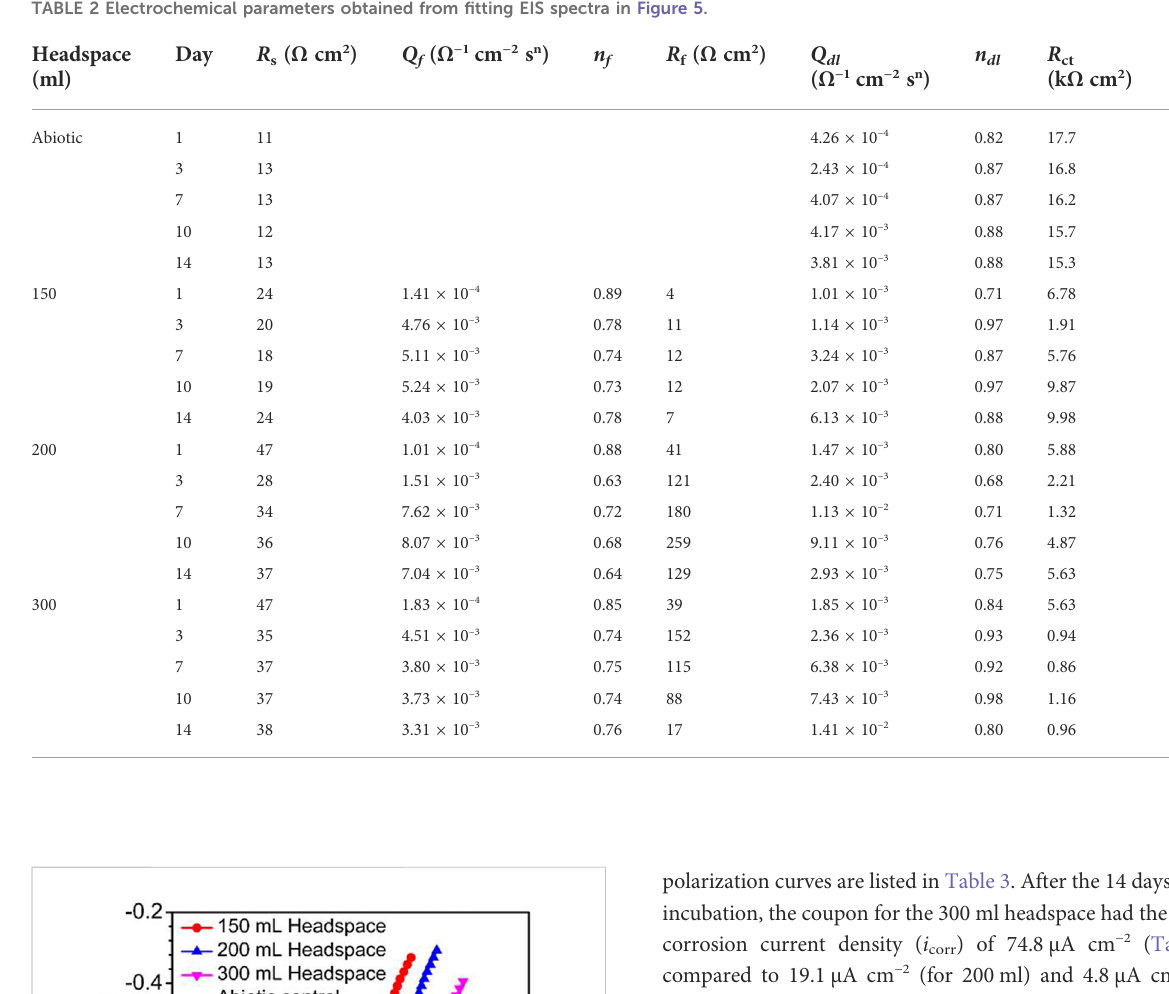
polarization curves are listed in Table 3. After the 14 days of SRB incubation, the coupon for the 300 ml headspace had the highest